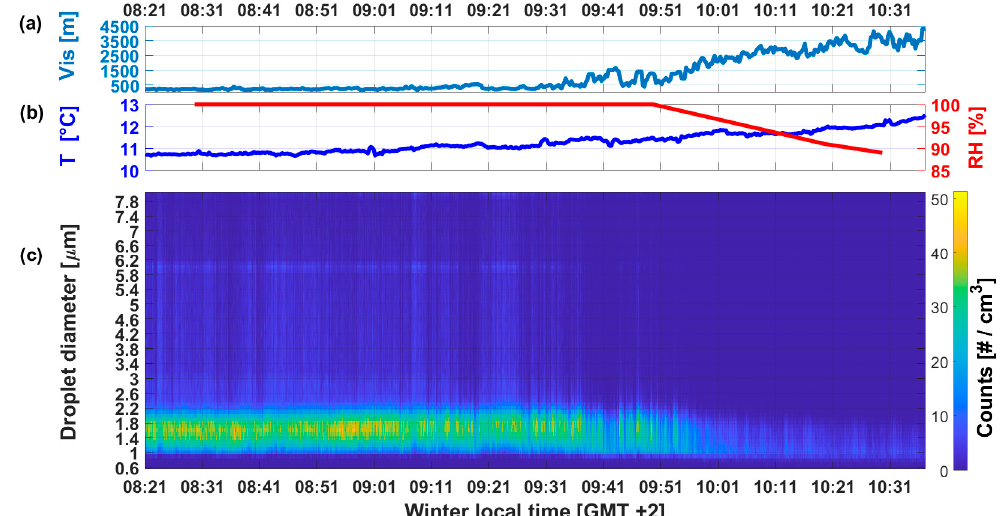
Figure 14. Evolution of the fog in time during the morning of 6 Jan 2021. ( a ): Visibility range. ( b ): Temperature (Ness Ziona) and relative humidity (Beit Dagan). ( c ): Droplets size distribution.